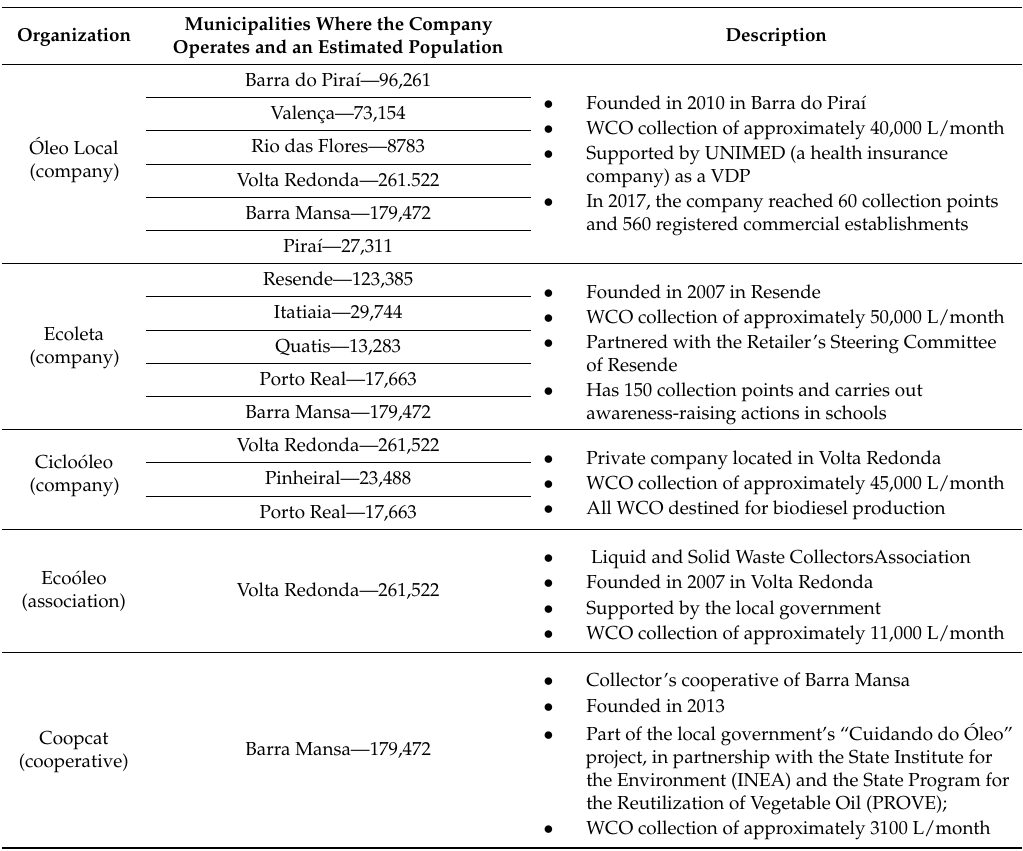
Table 3. WCO collection organizations in the Region of M é dio Para í ba Fluminense. Source: Created based on data from IBGE [54] and field